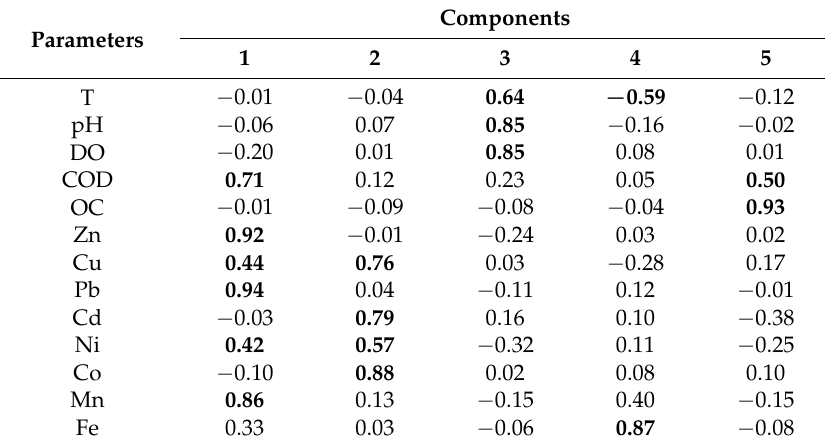
Table 4. Components extracted from the Principal Component Analysis.